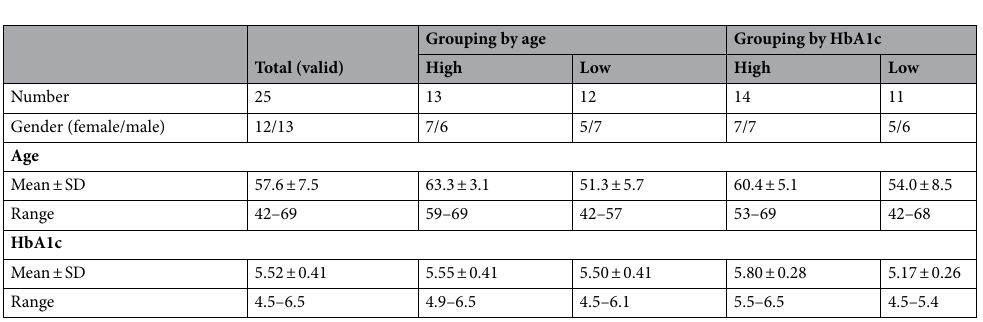
Table 1. Participant profiles grouped by age and HbA1c. The participants were 30 healthy Japanese adults. Of them, four participants were excluded from the analysis due to the following problems that occurred in at least one of the three measurement conditions: one with sensor detachment, one with noise in the presented sound, one with poor physical condition due to sleeplessness the night before, and one who was found to be regularly taking medication. In addition, one participant was excluded from the analysis because the data were judged as outlier using the Smirnov–Grubbs test. Thus, 25 participants were divided into two groups based on age or value of